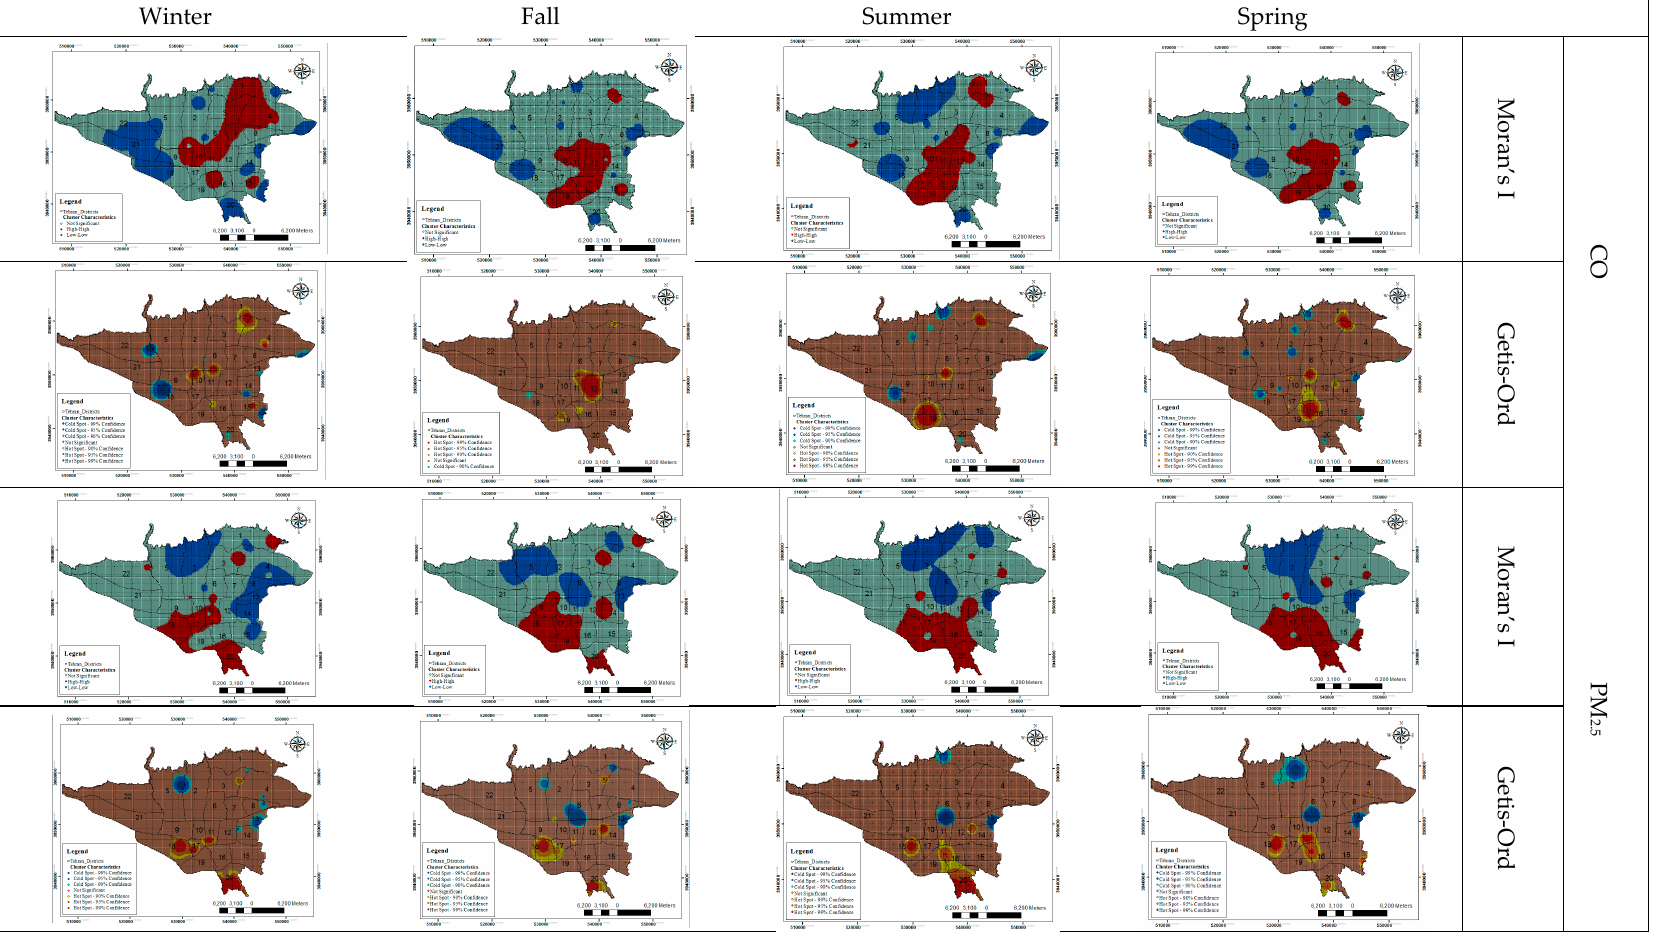
Figure 3. Seasonal clusters detected using local Moran’s I and Getis-Ord G i .